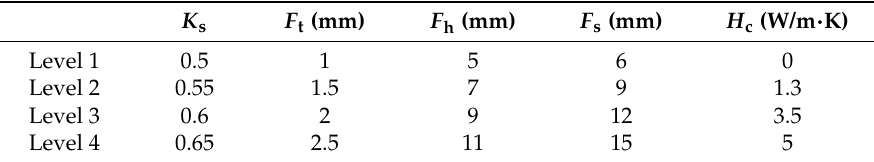
Table 6. Optimal parameters and the constraints of the motor.